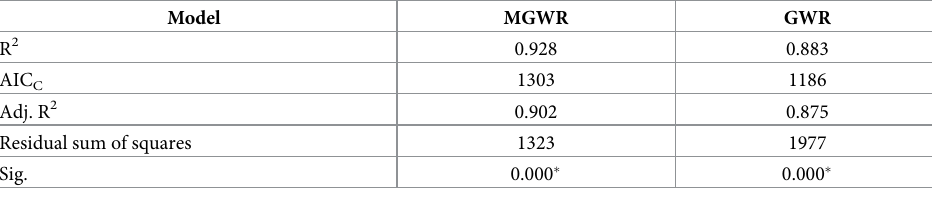
Table 7. Model index of GWR and